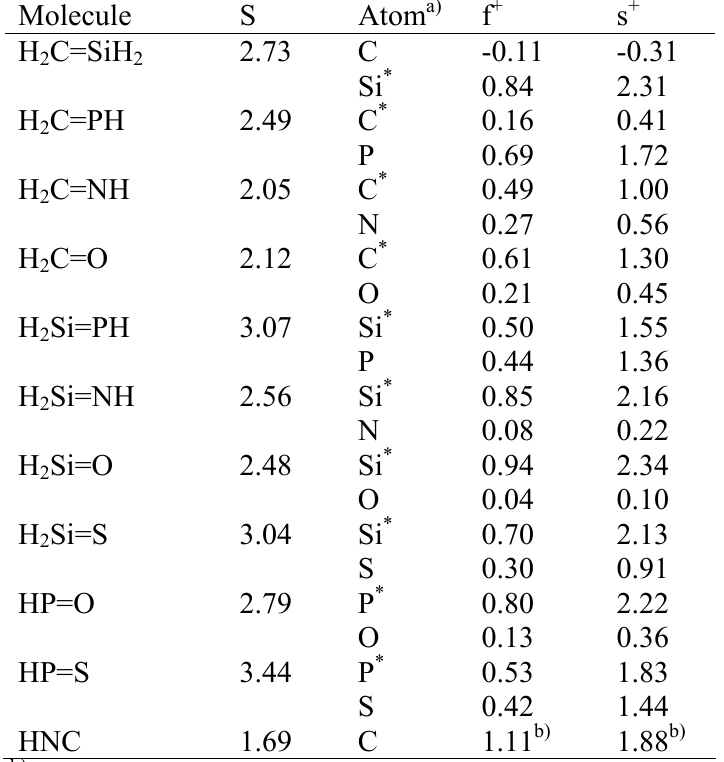
Table 2 . Global softness, condensed Fukui function and softness for nucleophilic attack for various dipolarophiles. The calculations were performed by using B3LYP/6-31G(d,p) method. Fukui function values were estimated from electrostatic potential (ESP) derived atomic